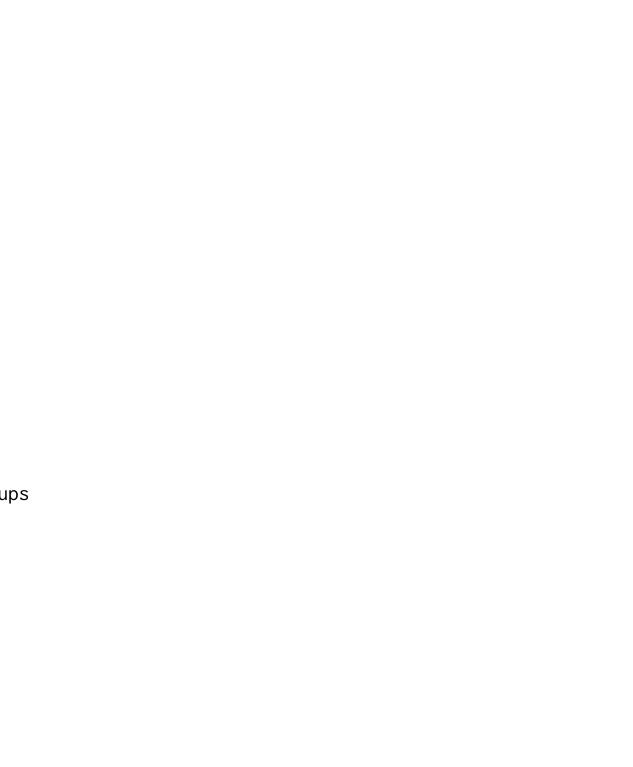
Textbox 1. Search strategy terms and phrases for the systematic literature review. Search term and